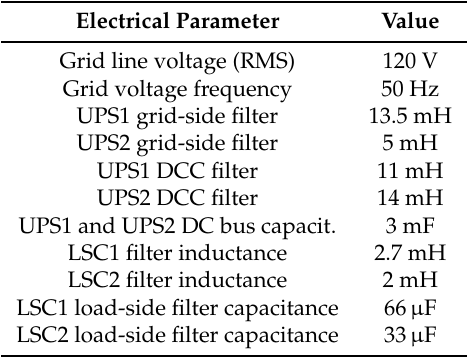
Table 3. Electrical parameters.